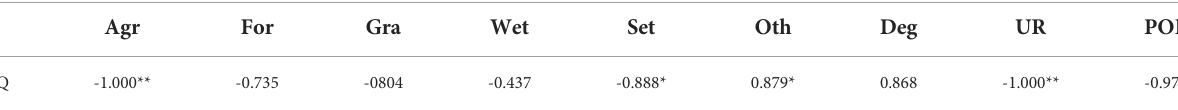
TABLE 2 Habitat quality and its correlation with in fl uencing factors.